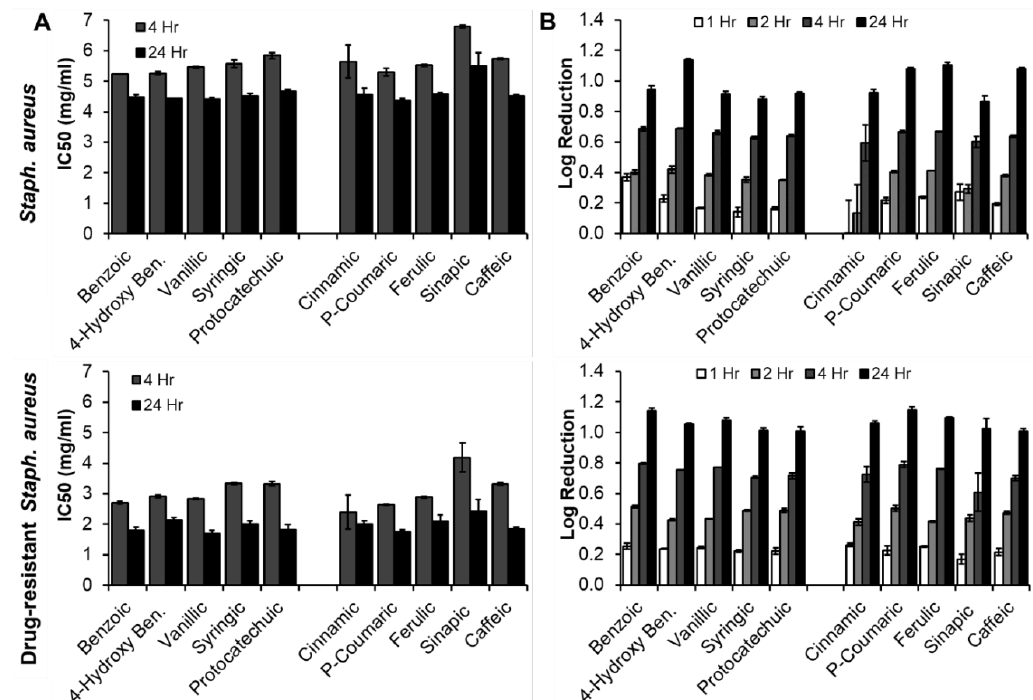
Figure 6. ( A ) IC50 and ( B ) log reduction of PAs against Staph. aureus (top row) and drug-resistant Staph. aureus (bottom row) . n = 3, mean ± standard deviation displayed.